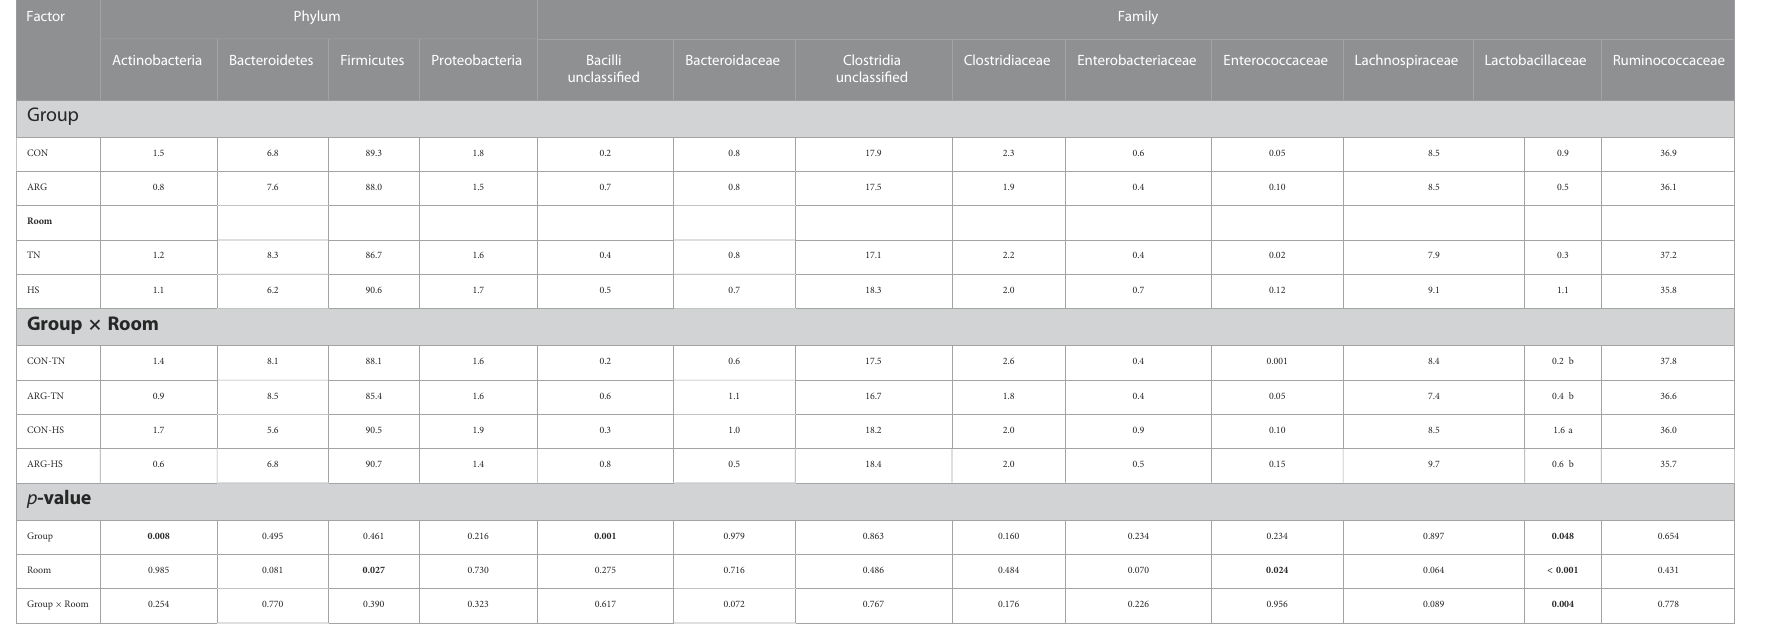
TABLE 5 Relative abundances (%) of important bacterial phyla and families in the cecal content of CON and ARG birds in the two rooms at